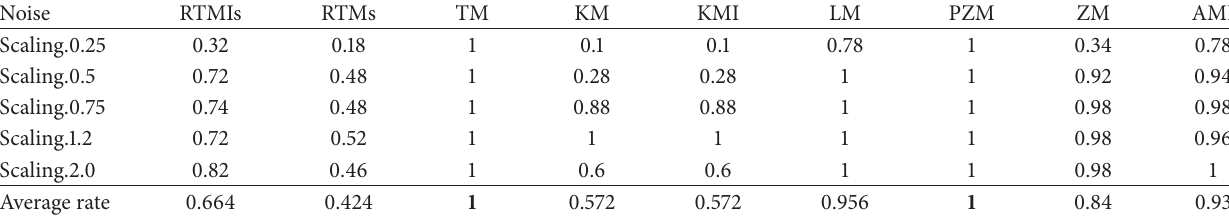
Table 2: Recognition rates of different moments about logos with scaling.